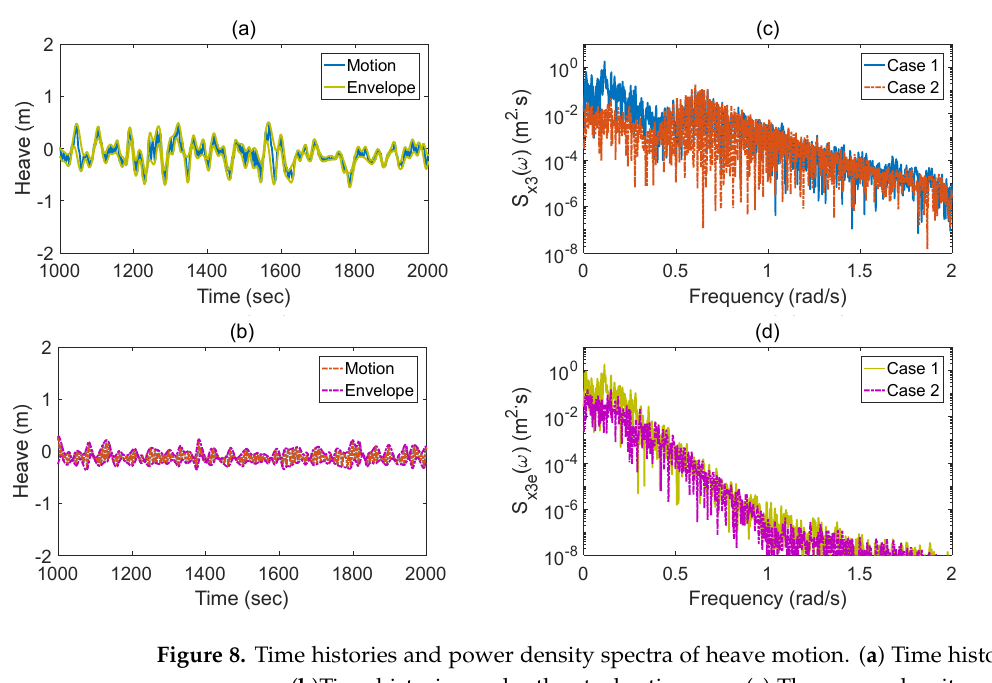
Figure 8. Time histories and power density spectra of heave motion. ( a ) Time histories under the wave group; ( b )Time histories under the stochastic wave; ( c ) The power density spectra of heave motion; ( d ) The power density spectra of heave motion envelope.